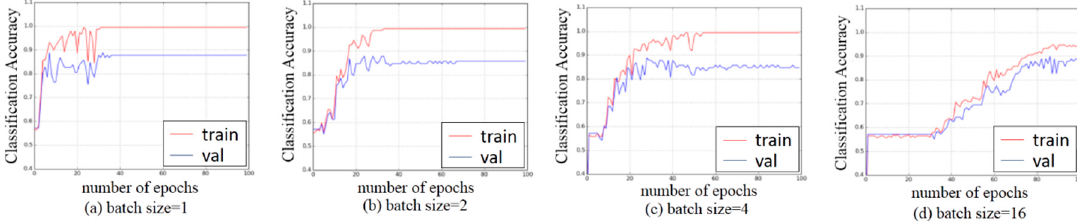
Figure 9. Comparison of classifier performance of different momentums. ( a ) momentum = 0.7; ( b ) momentum = 0.8; ( c ) momentum = 0.9; ( d ) momentum = 0.97.